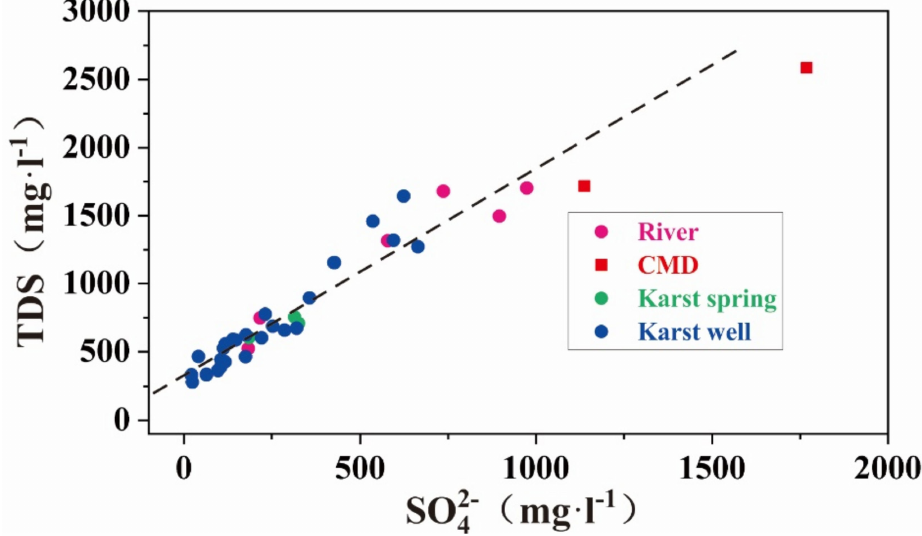
Figure 13. Relationships between TDS vs. SO 4 2 −